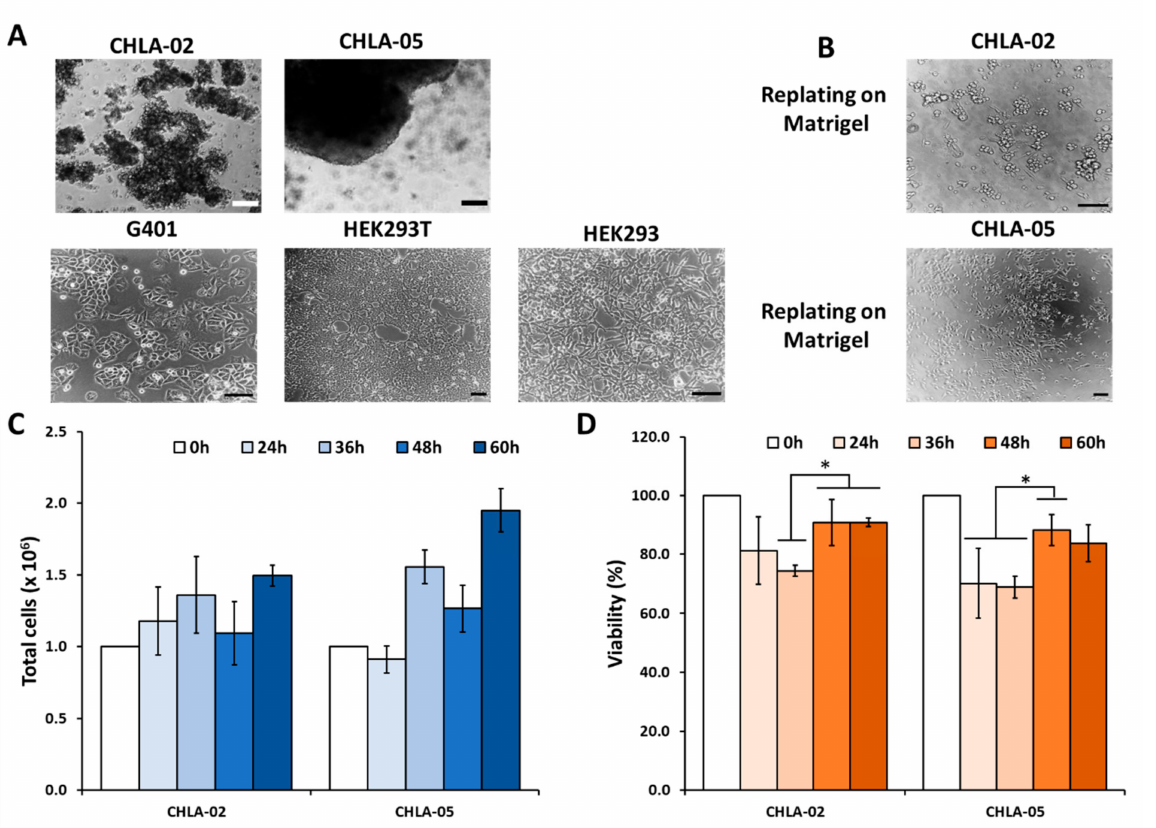
Figure 1. Morphology, proliferation, and cell viability. ( A ) The ATRT cell lines (CHLA-02 and CHLA-05) were suspended as aggregates when cultured in a normal well plate. The rhabdoid kidney tumor and the nonmalignant cell lines demonstrated attachment as a monolayer in culture. ( B ) Both ATRT cell lines showed attachment when cultured on a Matrigel -coated surface after 72 h. ( C ) Cell proliferation and ( D ) viability were measured at 24 h, 36 h, 48 h, and 60 h. *: p -value < 0.05, using the Student’s t -test. Scale bar: 200 µ